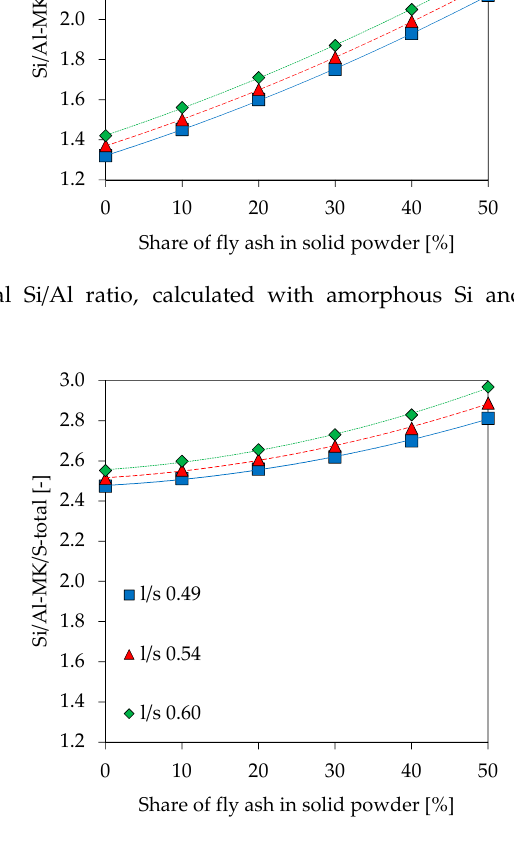
Figure 17. Theoretical Si/Al ratio, calculated with total amount of Si and Al, without fly ash (Si/Al-MK/S-total).